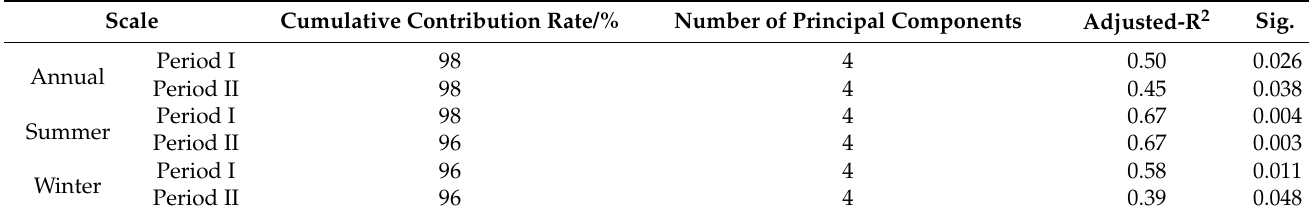
Table 2. The extraction of principal components and evaluation